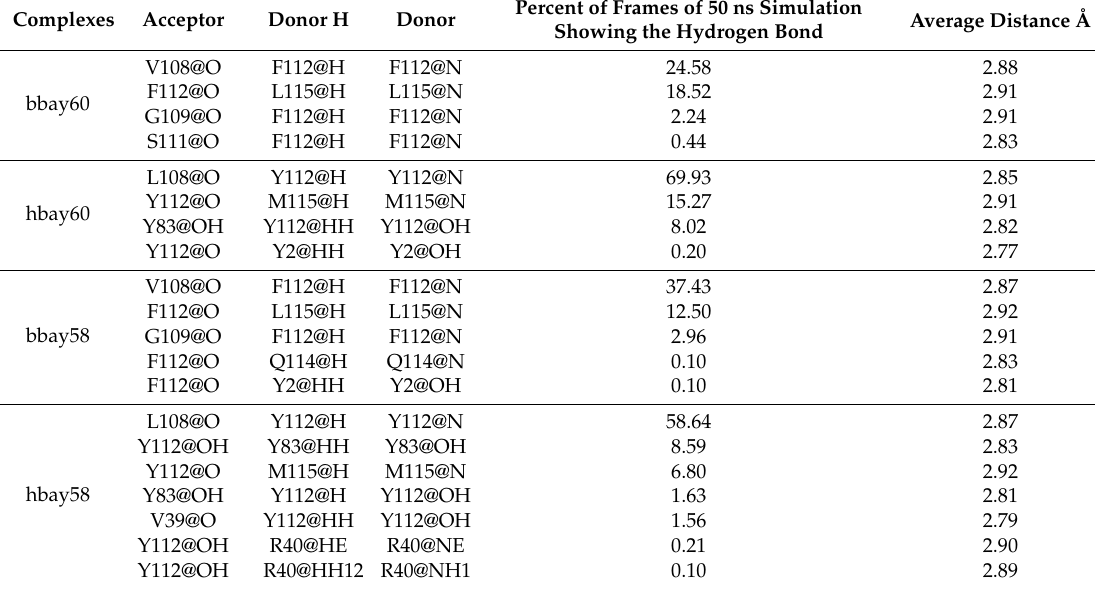
Table 1. Key residues involved in the hydrogen bonding network across binding pockets of bbay60, hbay60, bbay58 and hbay58 complexes. Hydrogen bond forming atoms: acceptor, donor hydrogen and donor atoms are also listed. The occupancy of a bond-hydrogen is given as percent of MD frames reporting the bond. Average distance of each H bond is also given as measure of the bond strength.